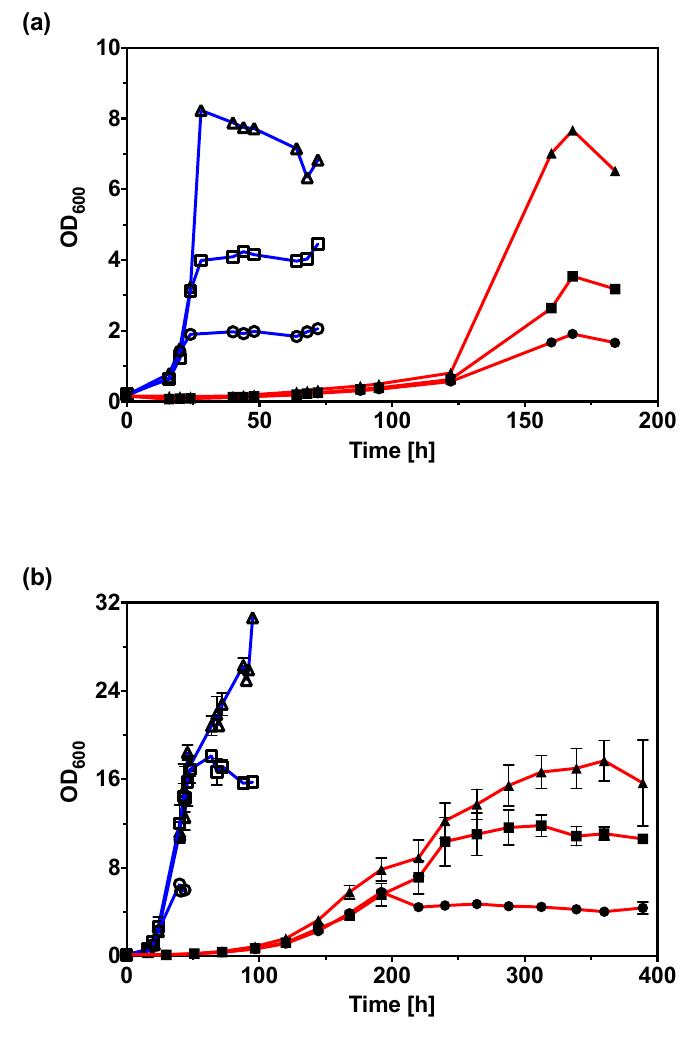
Figure 6. ( a ) Growth of C. necator H16 wild-type (red lines, solid symbols) and v6C6 variant (blue lines, open symbols) in 1% ( v / v ) (circle), 2% ( v / v ) (square), and 4% ( v / v ) (triangle) crude glycerol (sweetwater). ( b ) Growth of C. necator H16 wild-type (red lines, solid symbols) and v6C6 variant (blue lines, open symbols) in 0.5% ( w / v ) (circle), 1% ( w / v ) (square), and 2% ( w / v ) (triangle) laboratory-grade glycerol. Table 2. Specific growth rate of C. necator H16 and v6C6 variant in crude glycerol (sweetwater). Strain